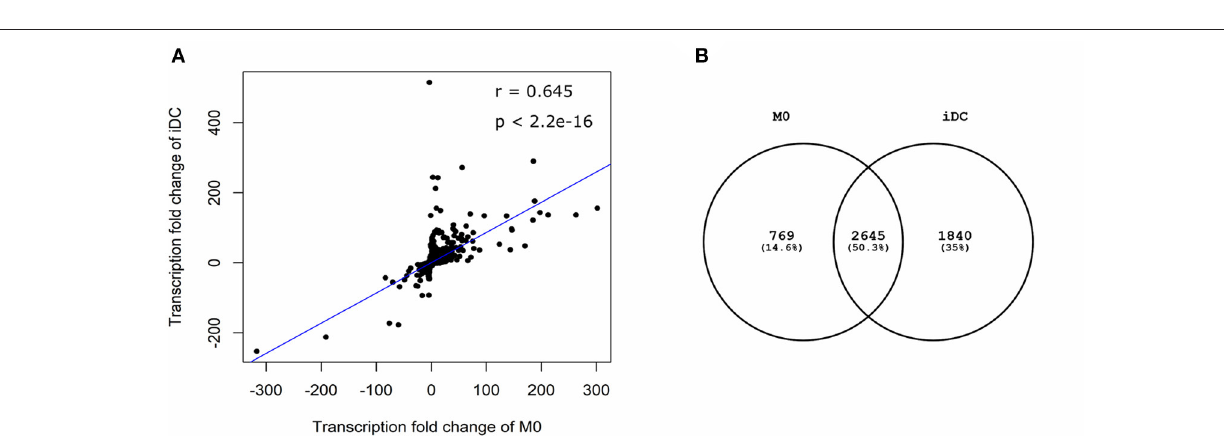
FIGURE 2 | Differential gene transcription in THP-1 derived macrophage- (M0) and dendritic-like cells (iDC) showed similarities and differences. THP-1 monocytes were non-treated or differentiated into M0 and iDC and the transcriptome was analyzed using microarray. Microarray analysis provided data on the transcriptome which was expressed as average fold change (FC) between differentiated cells vs. monocytes of 3 independent experimental replicates. Genes with an absolute value of FC > 2 and q value < 0.05 in M0 or iDC when compared to non-treated monocytes were considered to be significant. A scatter plot (A) showed the correlation between significantly differentially expressed genes in M0 and iDC. The Pearson correlation coefficient ( r ) and two-tailed p -value were analyzed using R studio. The Venn diagram (B) showed the numbers of shared or exclusive significantly differentially expressed genes in M0 and